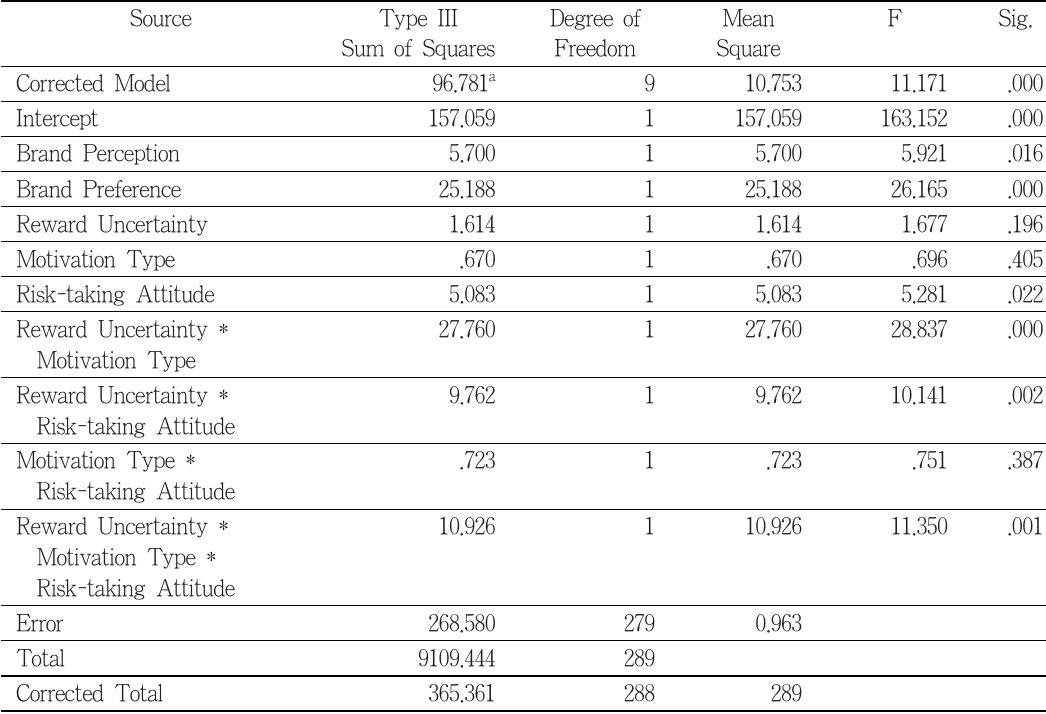
<Table 2> Three-way ANOVA – Tests of Between-Subjects Effects on the Participation Intention Dependent variable: Participation